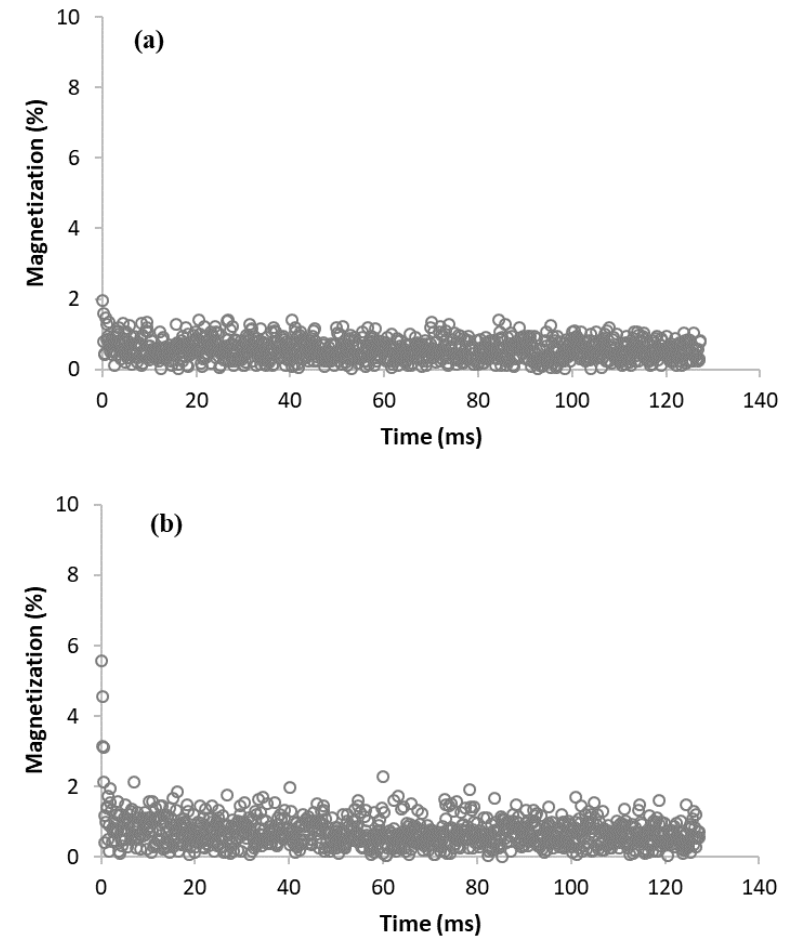
Figure 4. Relaxation curves of dried sample (MC-0) ( a ), and sample stored in atmosphere with 30% humidity (MC-30) ( b ).